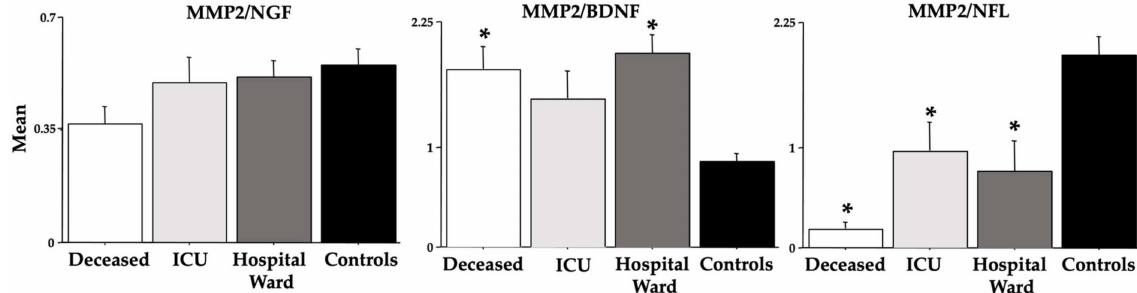
Figure 5. MMP-2 ratios vs. NGF, BDNF, and NFL in COVID-19 patients. The error bars indicate pooled standard error means (SEM) derived from the appropriate error mean square in the ANOVA. The asterisk ( p < 0.05) indicates post hoc differences with controls.